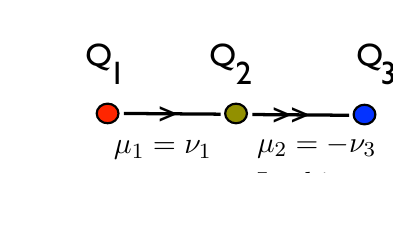
string tension scaling law, which is in good agreement with the available data, as described further below. We shall also elaborate on the similarity between con(cid:12)nement in dYM and the MIT Bag Model of the Yang-Mills